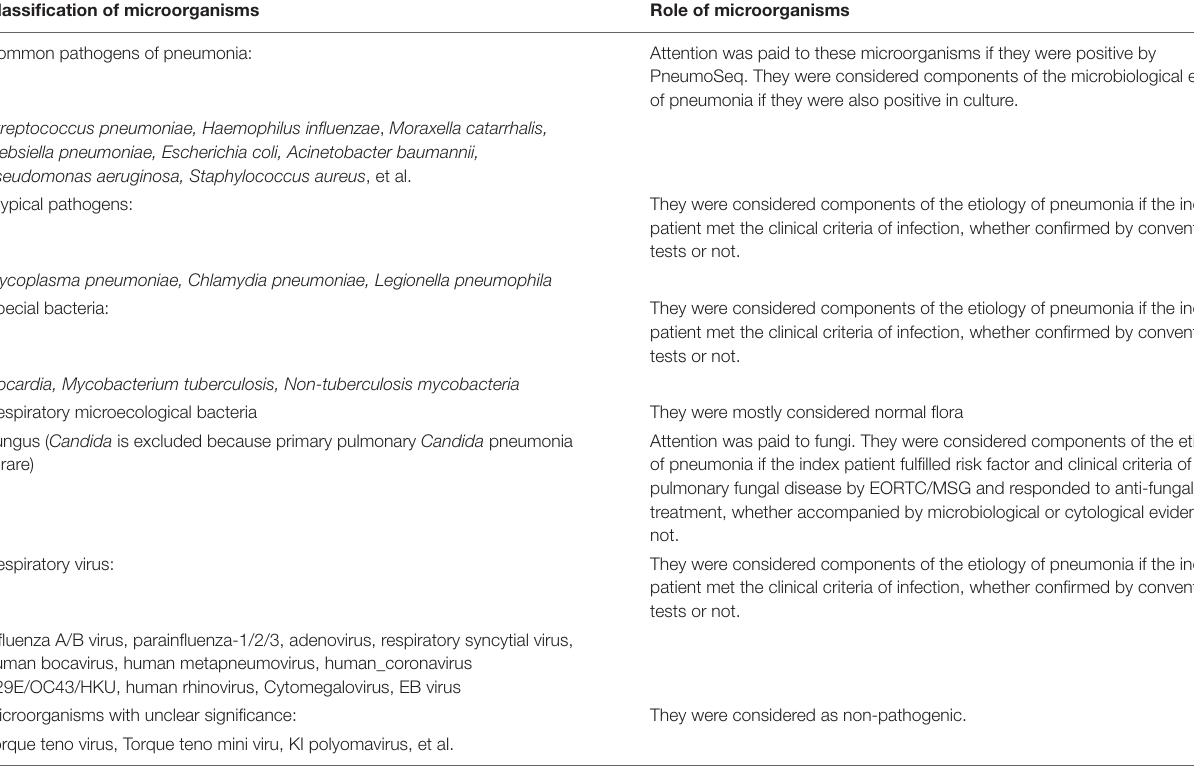
TABLE 2 | Evaluation guidance for role of microorganisms detected by PneumoSeq. Classification of microorganisms Role of microorganisms